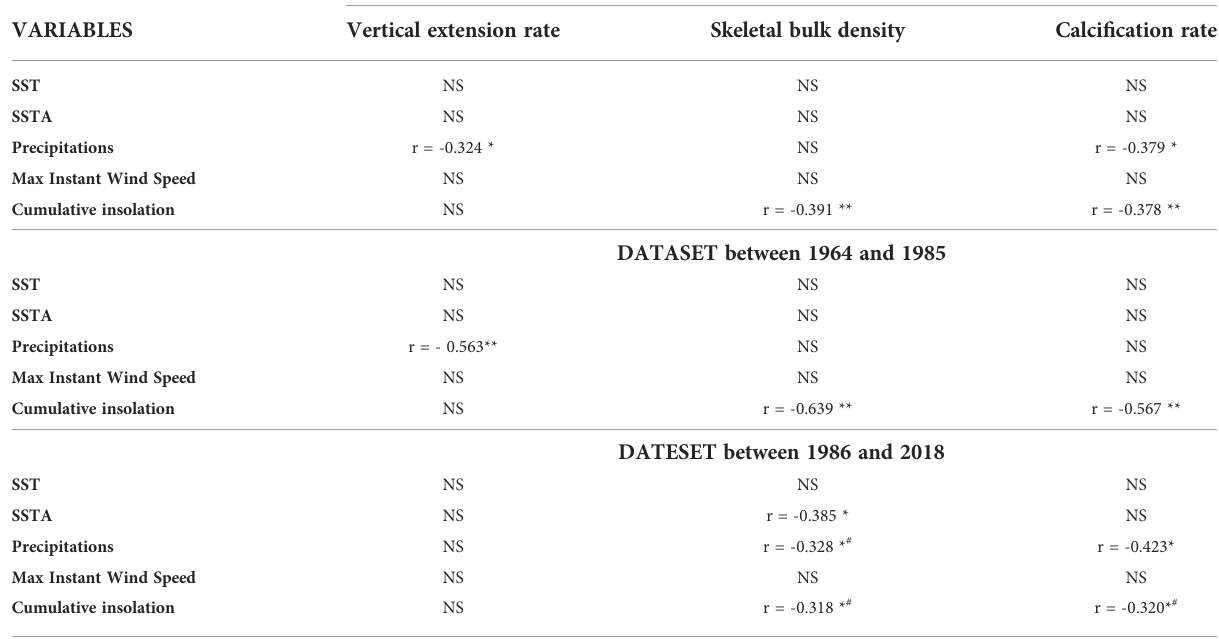
TABLE 2 Pearson ’ s correlations between the detrended coral growth variables and detrended environmental variables over the last 50 years and per period before or after the breakpoint. WHOLE DATASET (1964 – 2018)